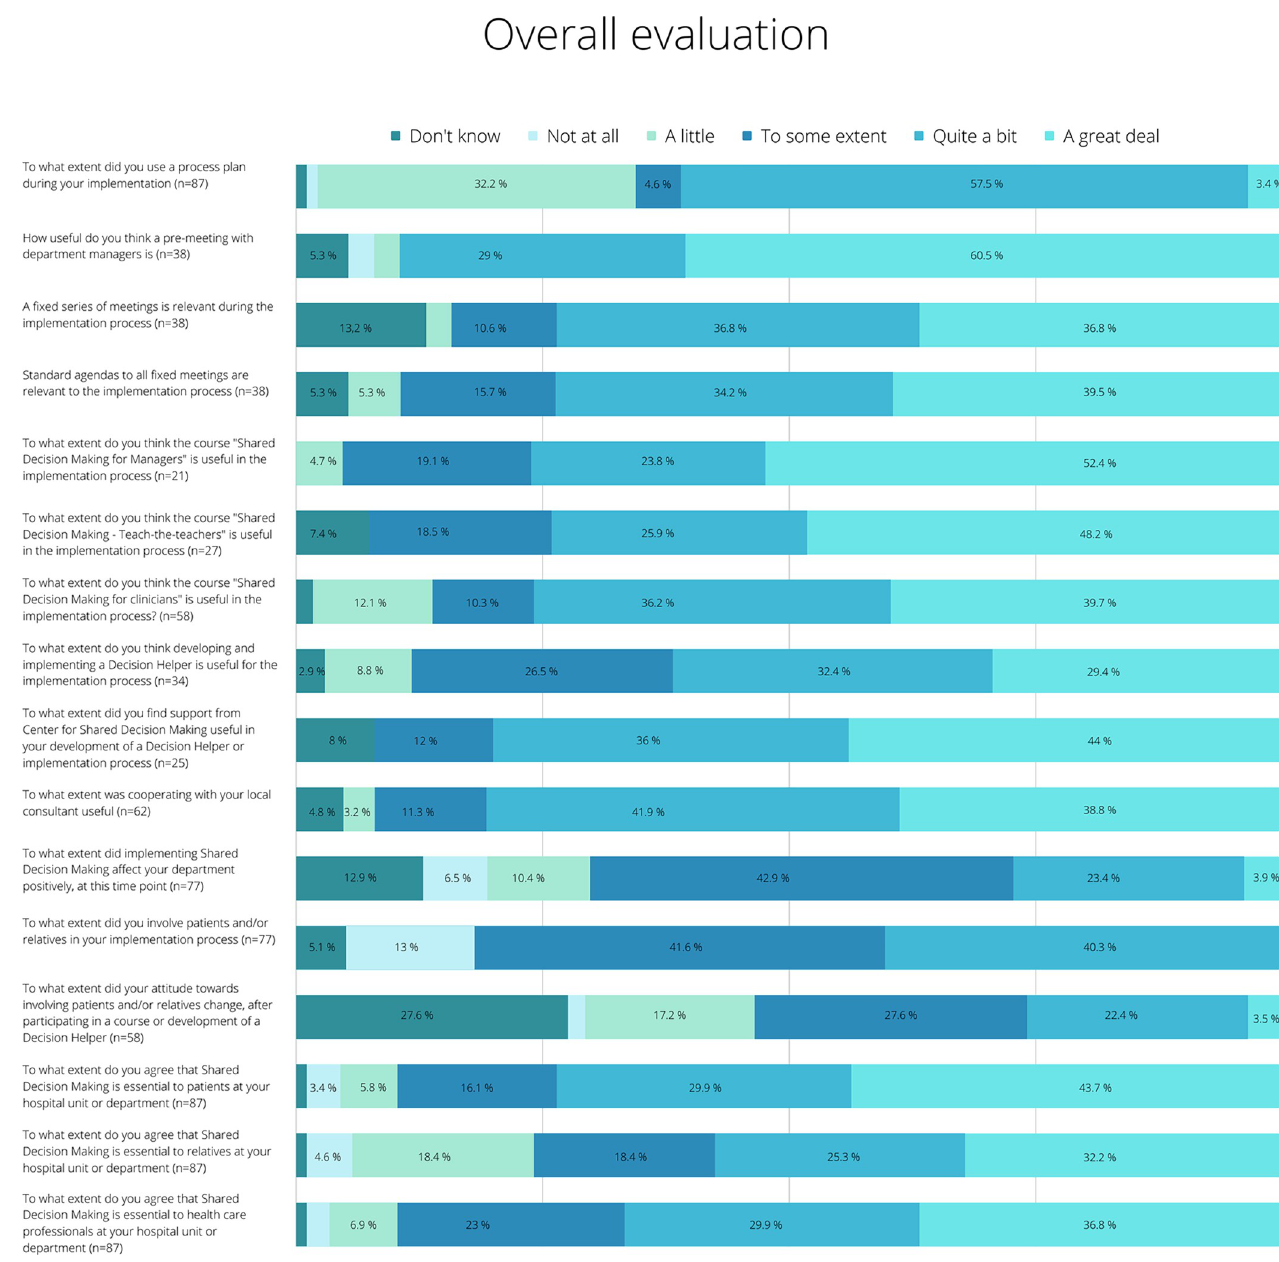
Fig 4. Overall evaluation of the implementation